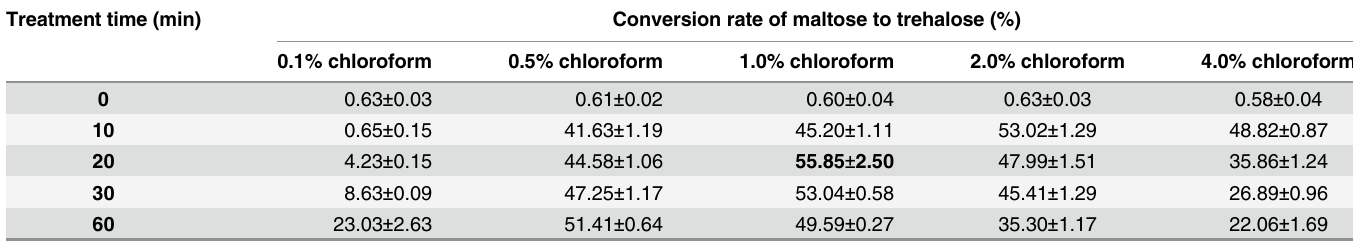
Table 2. Effects of chloroform dosageon and treatment time on the conversion rate of maltose to trehalose. Treatment time